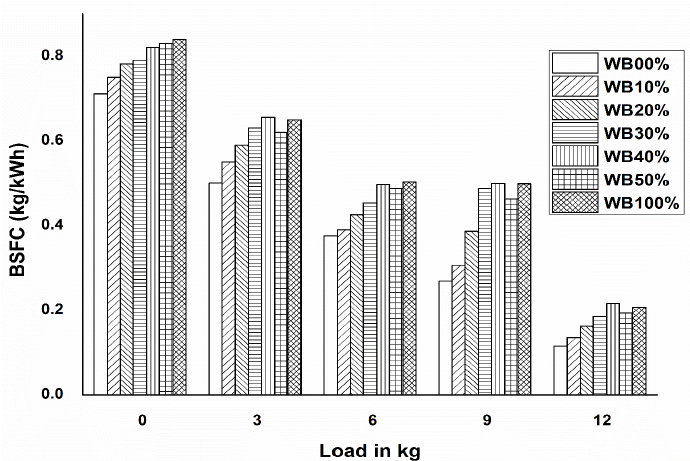
Figure 5. BSFC variation against load for biodiesel and the blends in kg (WB00% — diesel fuel; WB10% — biodiesel 10% + diesel 90%; WB20% — biodiesel 20% + diesel 80%; WB30% — biodiesel 30% WB10%—biodiesel 10% + diesel 90%; WB20%—biodiesel 20% + diesel 80%; WB30%—biodiesel + diesel 70%; WB40% — biodiesel 40% + diesel 60%; WB50% — biodiesel 50% + diesel 50%; WB100% — pure biodiesel). 30% + diesel 70%; WB40%—biodiesel 40% + diesel 60%; WB50%—biodiesel 50% + diesel 50%; WB100%—pure